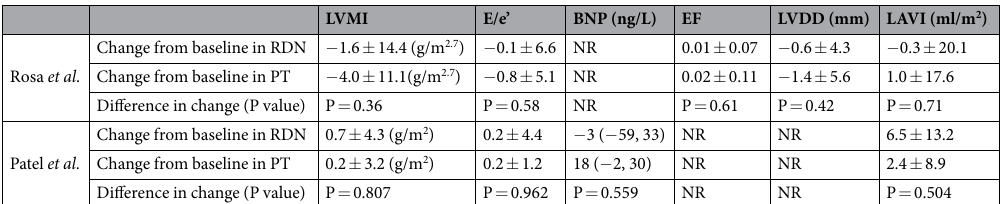
Table 3. Changes in cardiac structure and function from baseline to 12 months in randomized controlled trials. Data are presented as mean ± standard deviation or median (quartile 1, quartile 3). LVMI: left ventricular mass; E/e’: